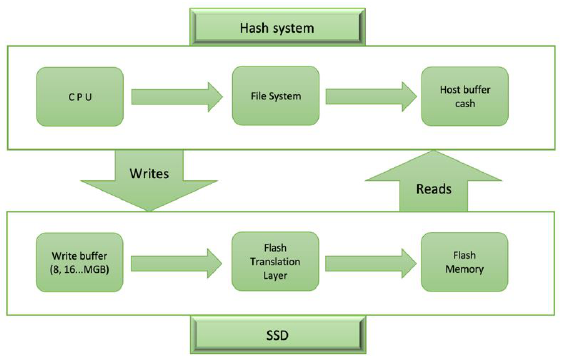
Figure 2. Request from the file